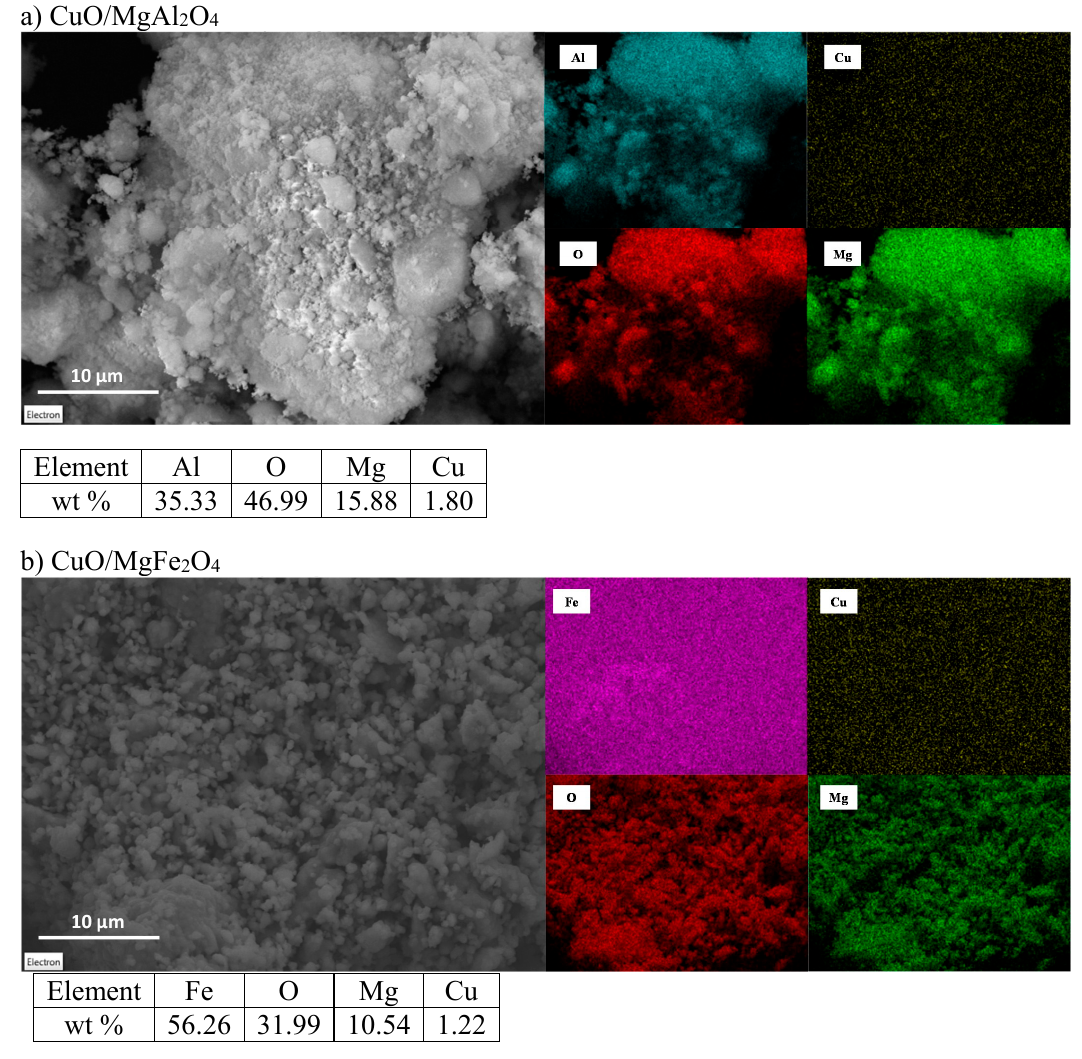
Figure 4. EDX elemental dot mapping analysis of ( a ) CuO/MgAl 2 O 4 and ( b ) CuO/MgFe 2 O 4 nanocatalysts.